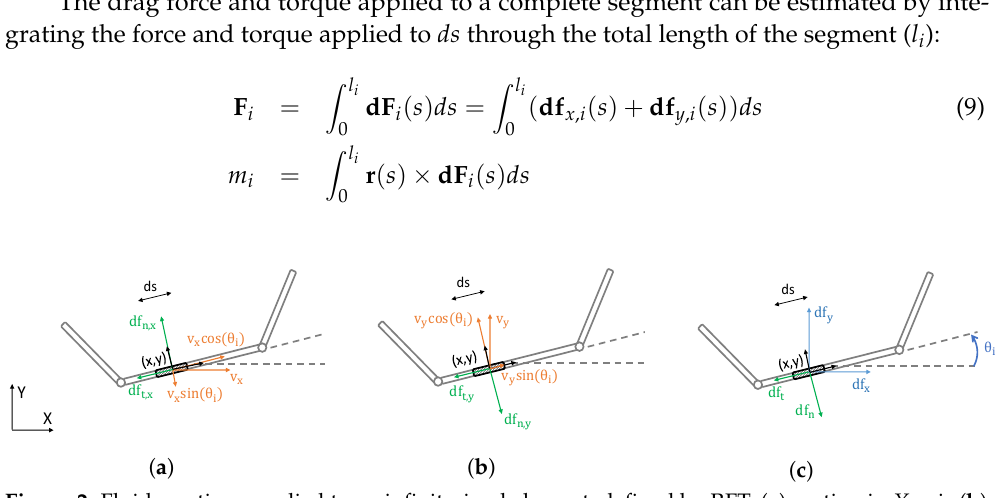
Figure 2. Fluid reactions applied to an infinitesimal element, defined by RFT: ( a ) motion in X axis ( b ) motion in Y axis ( c ) total drag